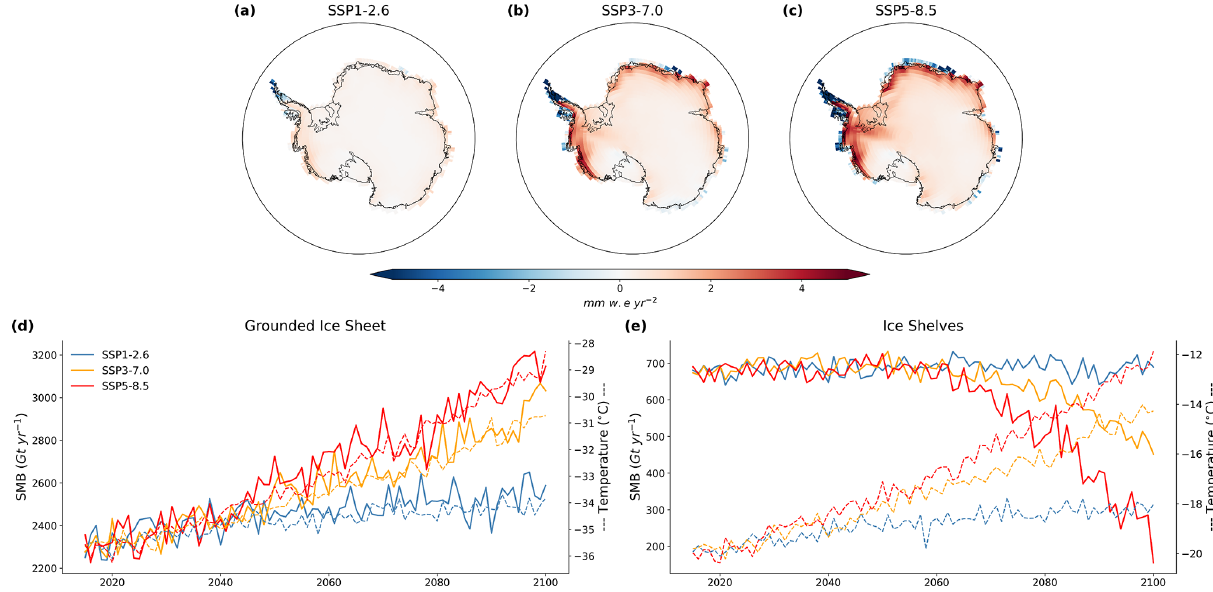
Figure 8. Future (2015–2100) SMB in CESM2. (a–c) SMB trend from low (SSP1–2.6), middle (SSP3–7.0), and high (SSP5–8.5) Shared Socioeconomic Pathways. (d) Time series of annual grounded SMB (left axis, solid lines) and temperature (right axis, dashed lines) from different CESM2 SSPs. (e) Time series of annual SMB and temperature over ice shelves.